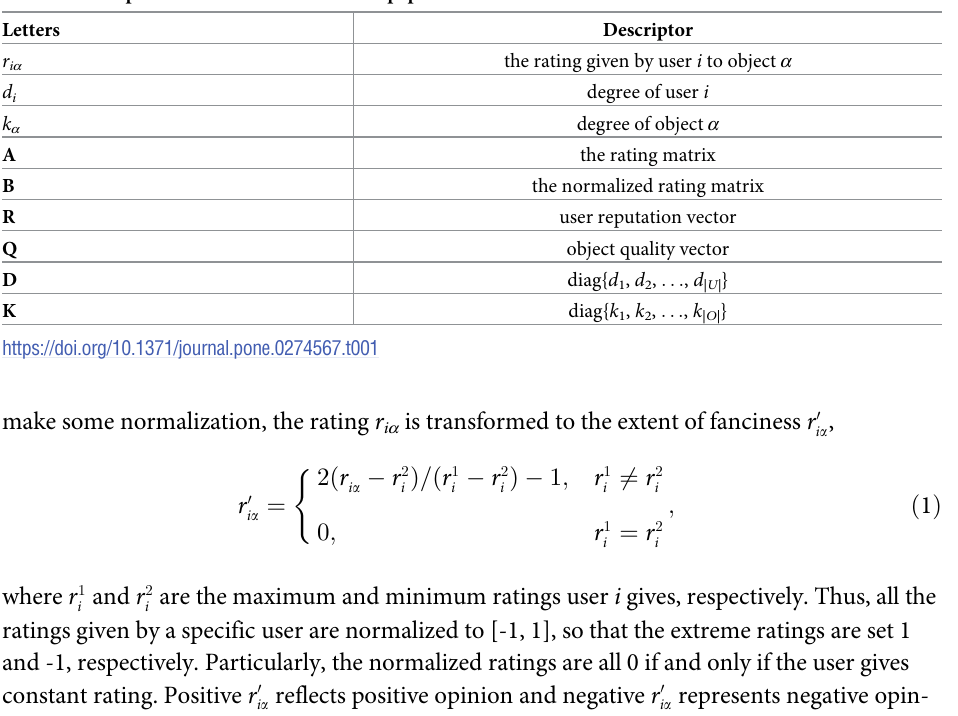
Table 1. Descriptor table of letters used in this